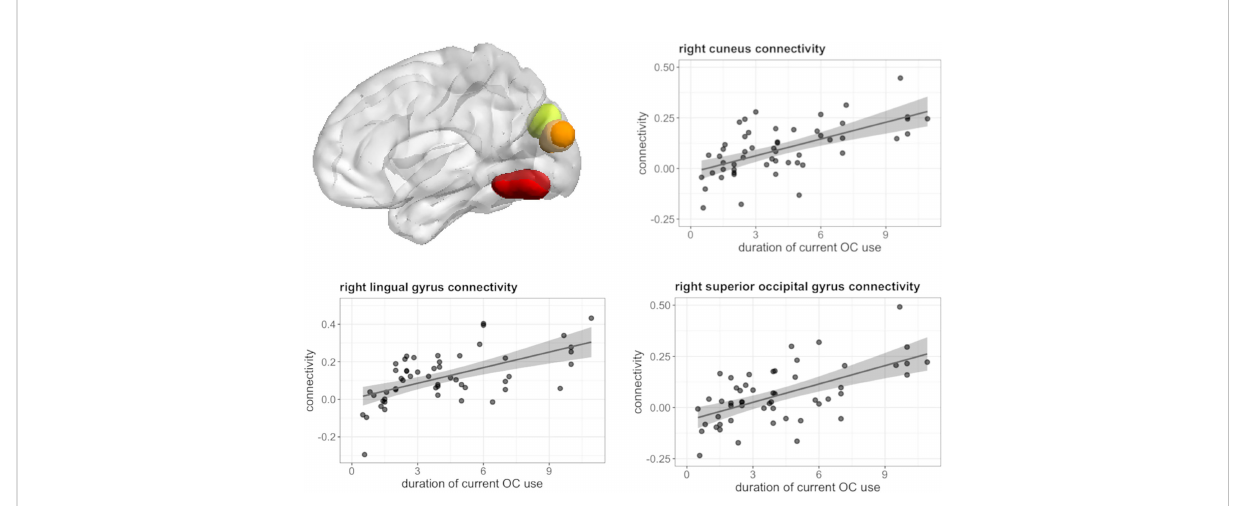
FIGURE 7 Positive association between duration of OC use and connectivity between left hippocampus and right cuneus, lingual gyrus, superior occipital gyrus in current users during